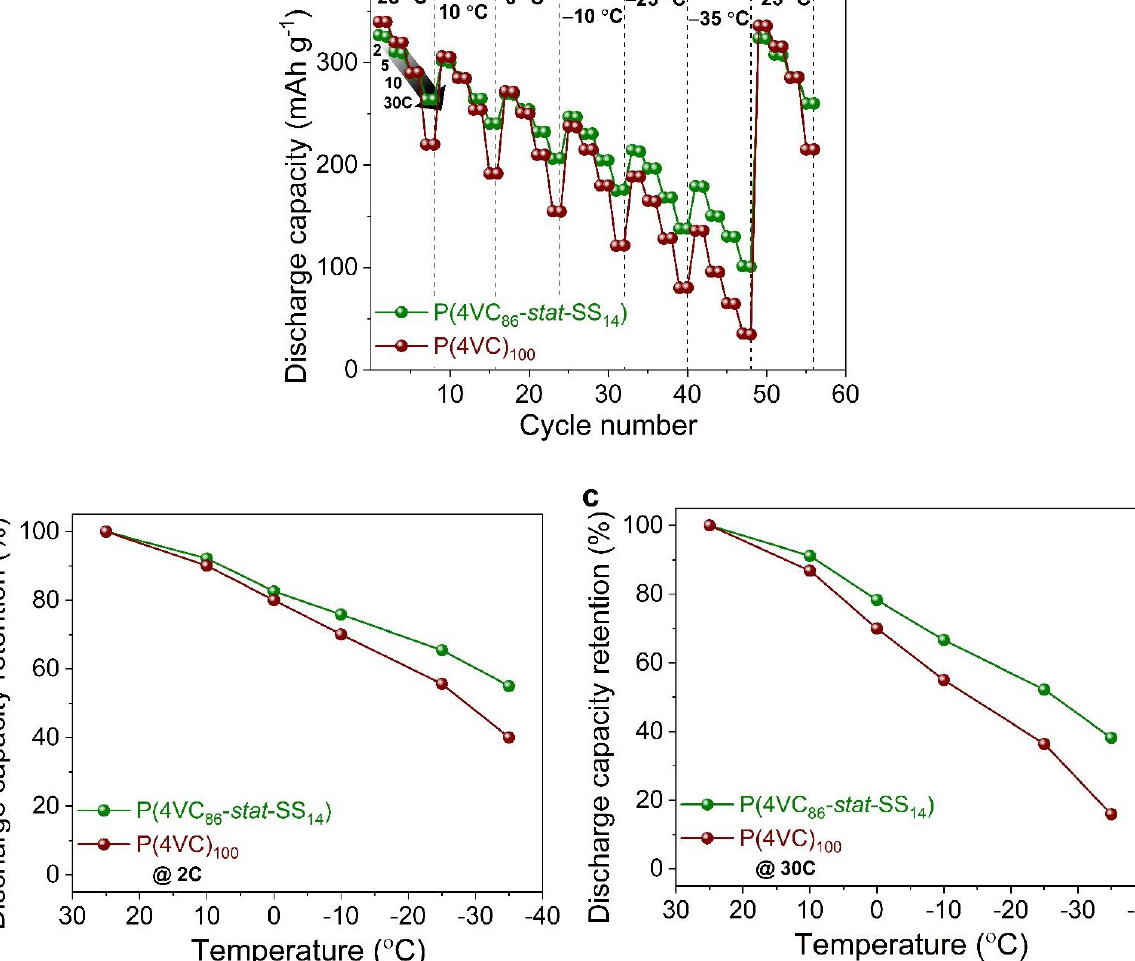
Figure 3. Comparative rate performance of Zn||P(4VC) 100 and Zn||P(4VC 86 - stat -SS 14 ) cells at different temperature and at different C-rates. ( a ) Discharge capacity vs. cycle number, recorded at different C-rates (from 2 C to 30 C) and at different temperature (from +25 °C to −35 °C). ( b , c ) Discharge capacity retention at 2 C ( b ) and at 30 C ( c ). The discharge capacities at lower temperature are normalized with respect to the discharge capacity at 25 °C.